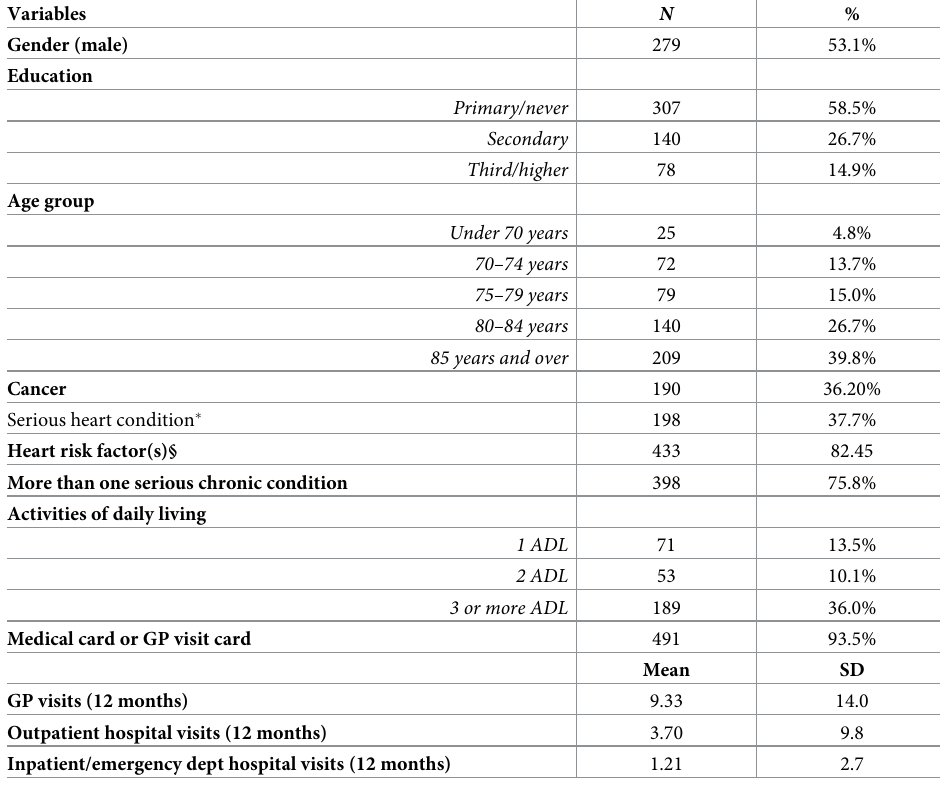
Table 1. Descriptive data of total sample ( n =